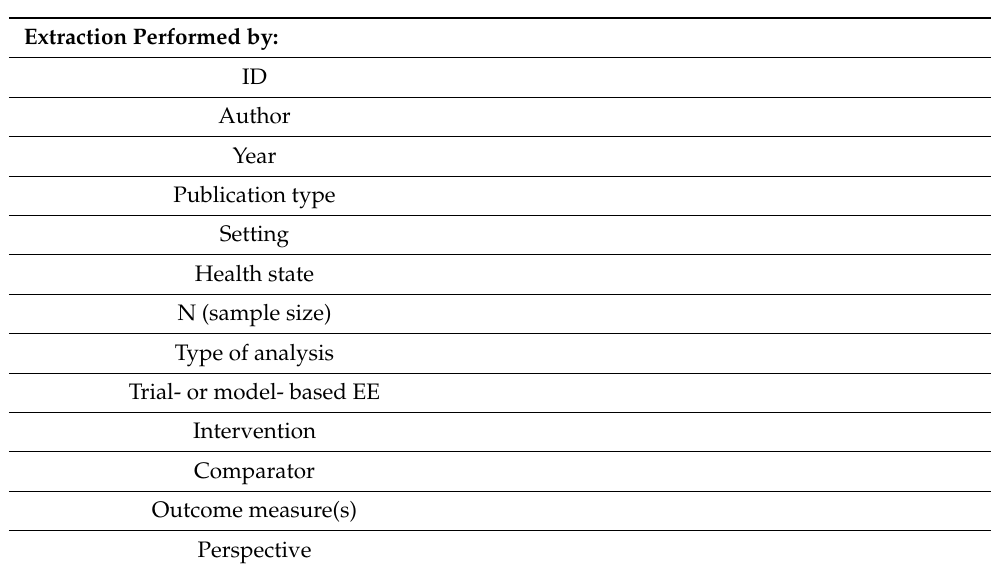
Table A2. Extraction